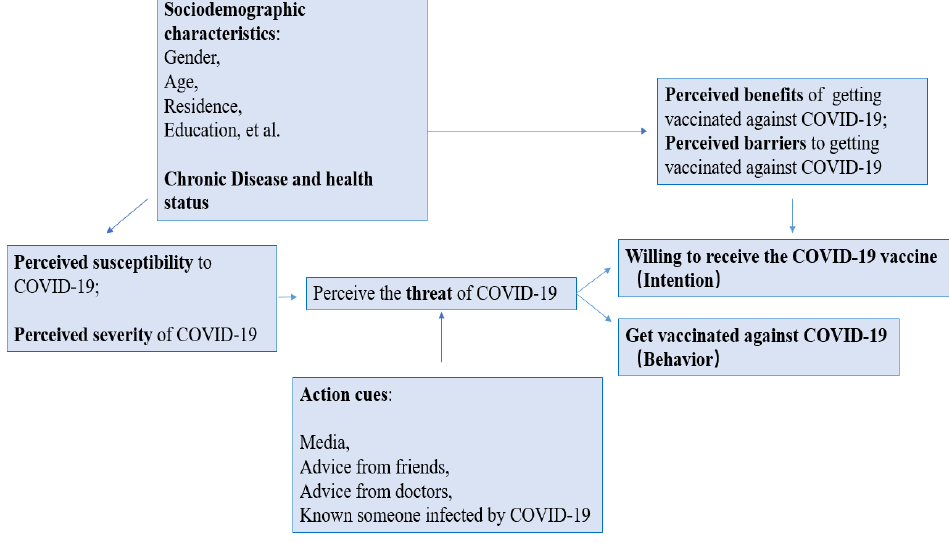
Figure 1. Conceptual framework of the determinants of COVID-19 vaccine acceptance (based on